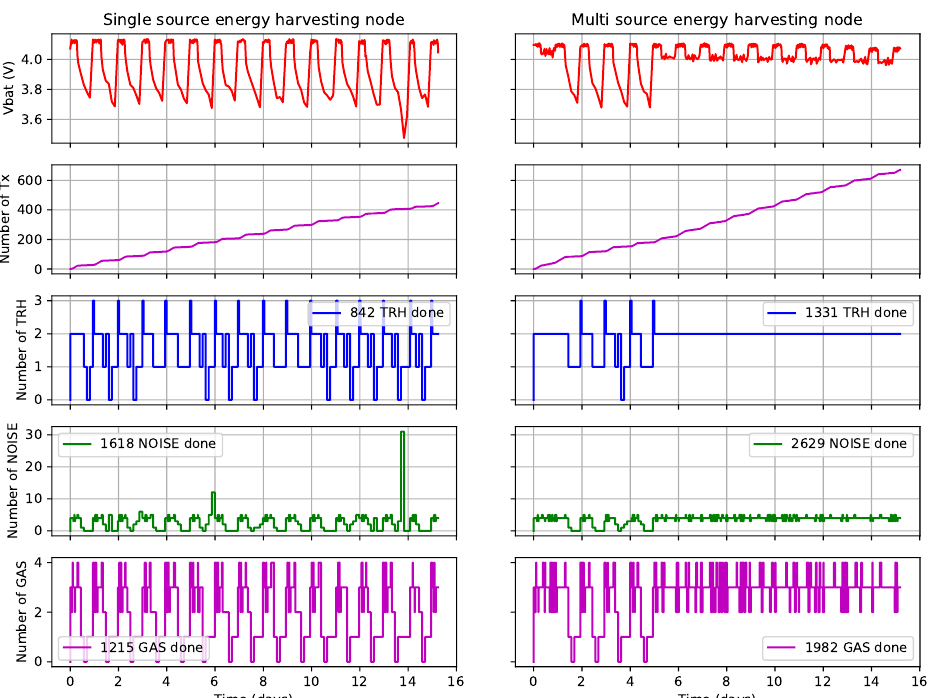
Figure 5. Number of task executions for single- and multi-source energy-harvesting